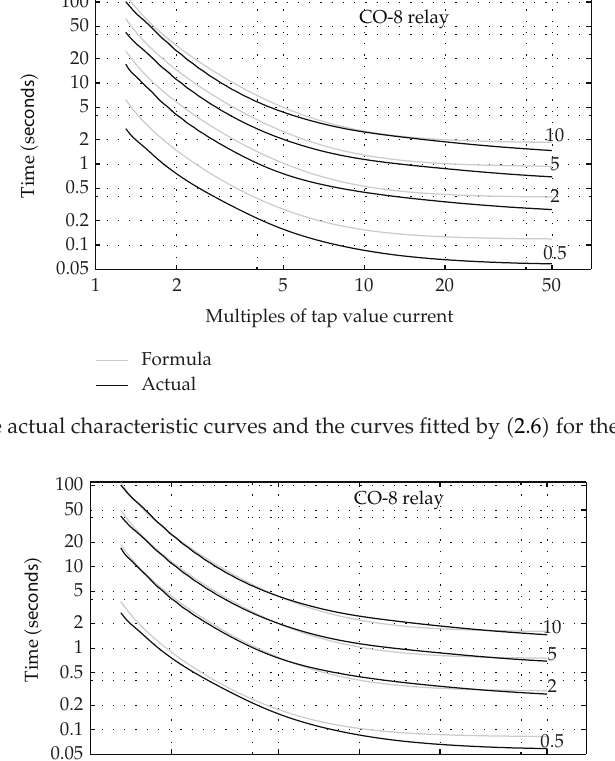
respectively. The fitted curve di ff ers considerably from the actual characteristic curve and cannot be used directly as a good